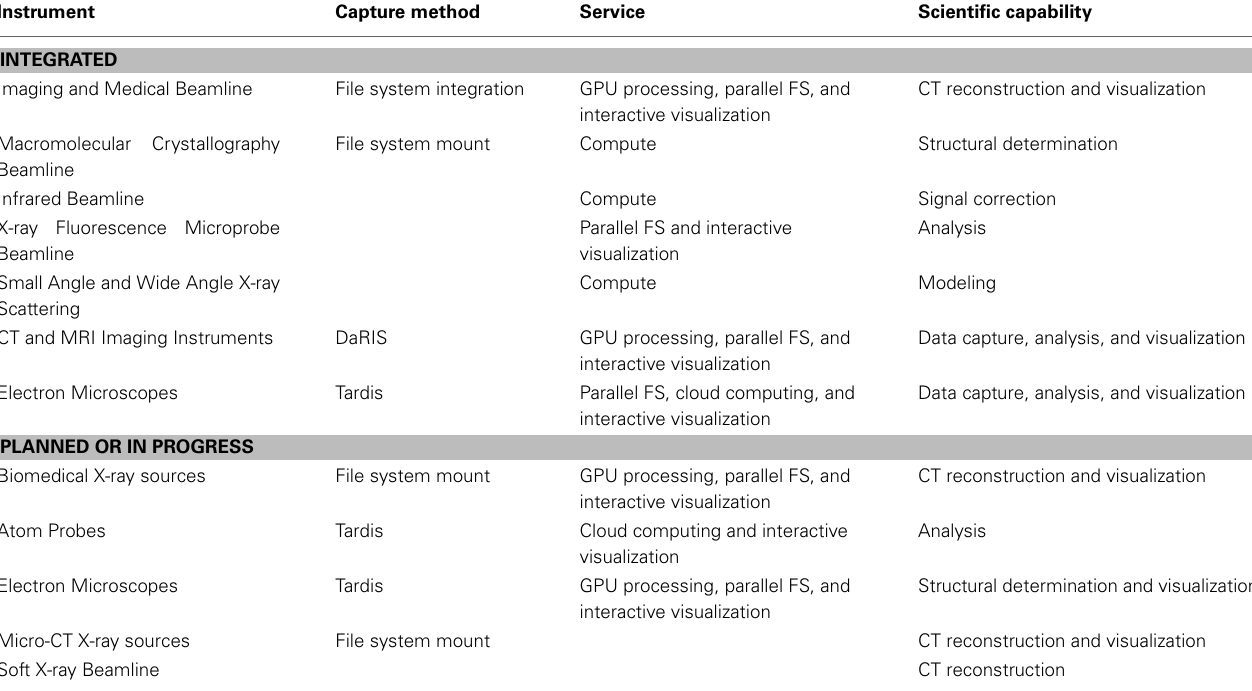
Table 2 | The computational systems and file system access associated with the imaging instrumentation integrated with MASSIVE and the Characterization Virtual